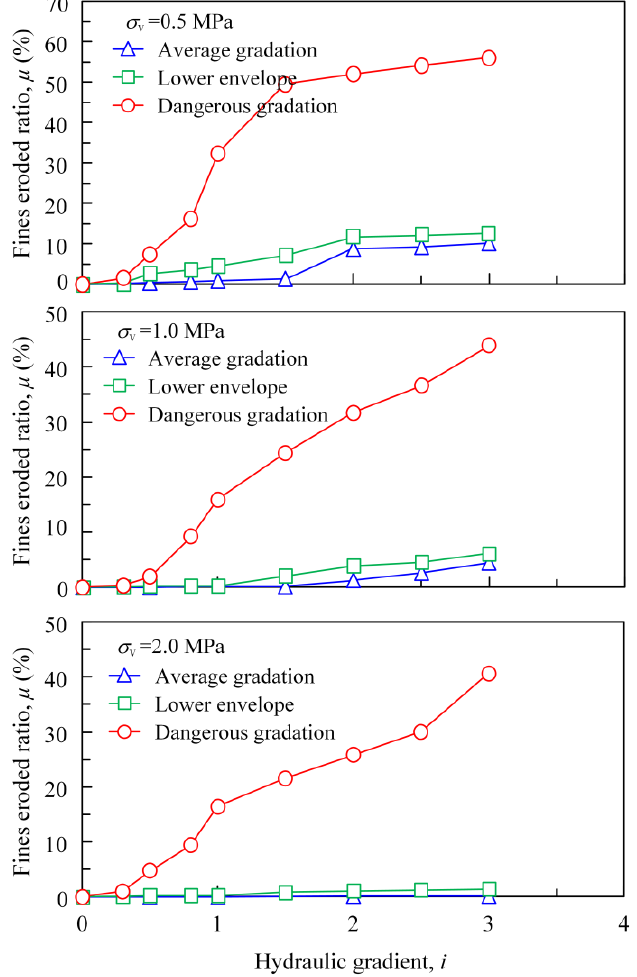
Figure 7. Fine particle erosion ratio versus imposed hydraulic